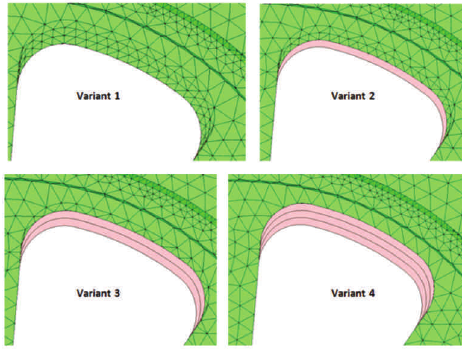
Fig. 13. Four variants of the hole shape